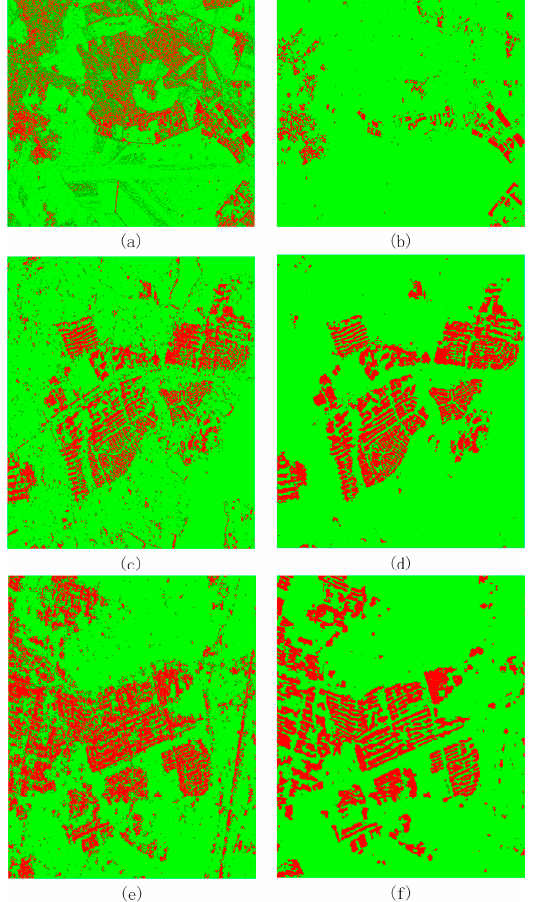
Figure 9. Comparison of using the MLP and CNN methods. ( a , b ) is the experimental result under ESAR data, ( c , d ) is the experimental result under GF-3 data, and ( e , f ) is the experimental result under RADASAT-2 data. Where ( a , c , e ) is the experimental result of the MLP and ( b , d , f ) is the experimental result of the CNN.